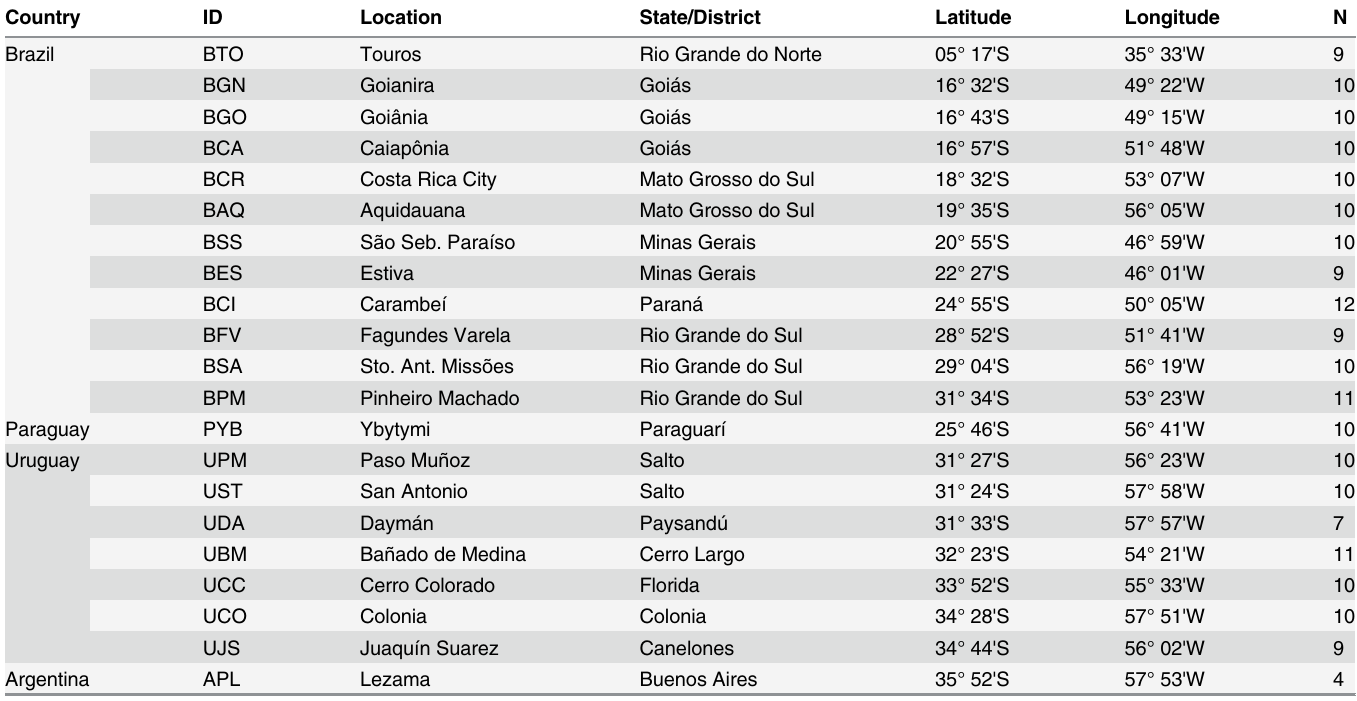
Table 1. NWS fly sampling